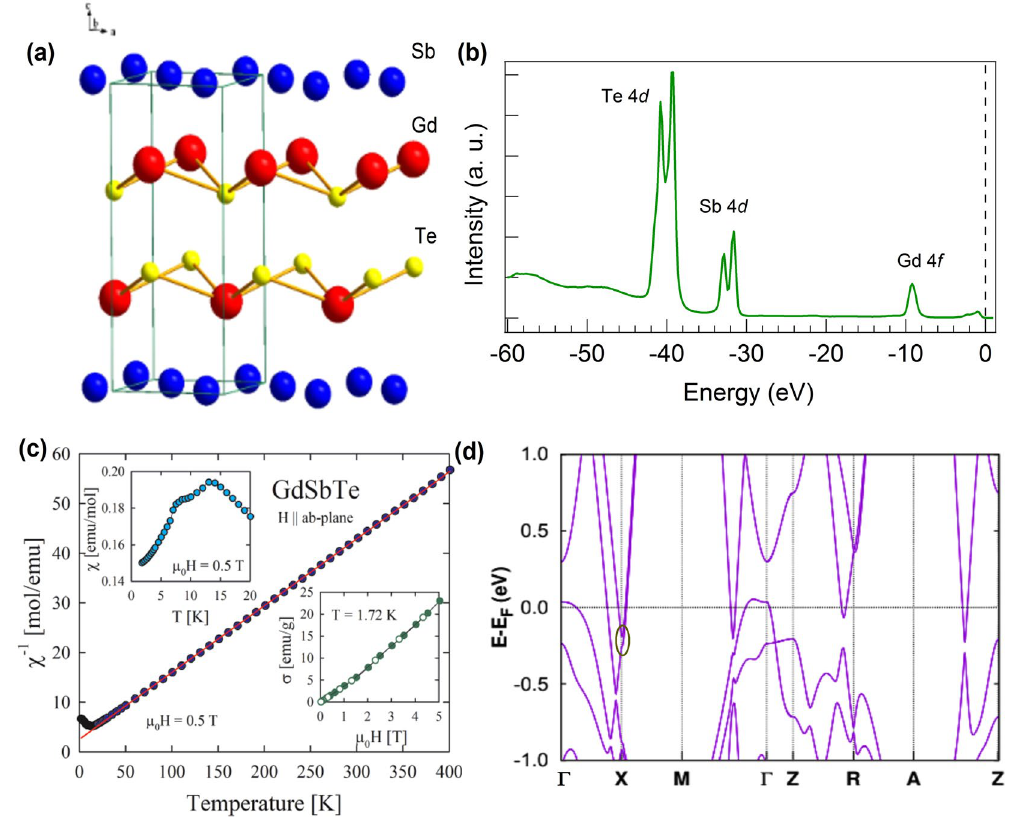
Figure 1. Crystal structure and sample characterization of GdSbTe. ( a ) Tetragonal crystal structure. Layers of Sb atoms form a square net. Sheets of Gd atoms are separated by two Te layers. ( b ) Core-level spectrum. Here, we clearly observe sharp peaks due to Te 4 d (~40 eV), Sb 4 d (~33 eV) and Gd 4 f (~8.5 eV) states. The black dashed line represents the Fermi level. ( c ) Temperature dependence of the reciprocal magnetic susceptibility measured in a magnetic field of 0.5 T applied within the crystallographic a-b plane. Solid line represents the fit of Curie-Weiss law to the experimental data. Upper inset: low-temperature magnetic susceptibility data. Lower inset: magnetic field variation of the magnetization taken at 1.72 K with increasing (full circles) and decreasing (open circles) magnetic field strength. ( d ) Ab-initio calculated bulk band structure along the high-symmetry directions. Red circle indicates the approximate position of the Dirac